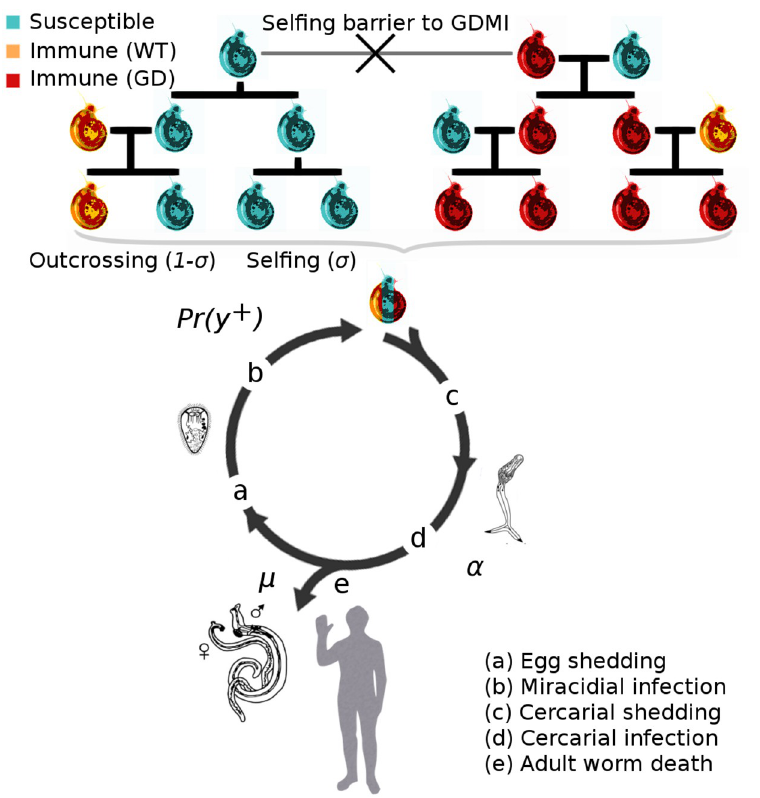
Fig 1. Conceptual diagram of the integrated epidemiological and population genetic model describing the evolution of immunity to schistosome infection in the snail population. (a) High worm burden in the human population increases the force of infection on the snail population, which positively selects for immune snail genotypes. (b) Miricidial infection of susceptible snails is density-dependent. (c) Evolution of immunity in the snail population reduces cercarial transmission to humans, thereby regulating parasite densities at an endemic equilibrium. GDMI is inherited more rapidly than natural immunity only when outcrossing occurs. (d) Infection of humans is proportional to cercarial output, and a negative binomial distribution of adult worms in the human population influences mating success and egg production (Table B in S1 Text). Existing literature does not consistently support the role of variable human immunity in epidemiological models in endemic regions, therefore immunity in the human population is assumed constant. (e) Mortality of adult worms occurs via constant natural mortality and MDA treatment. Three snail genotypes are modeled: susceptible to infection, innately immune (wild type), and gene drive mediated immune. Iteroparitive reproduction and mortality of these genotypes is modeled with explicit fecundity and viability components of fitness (see S1